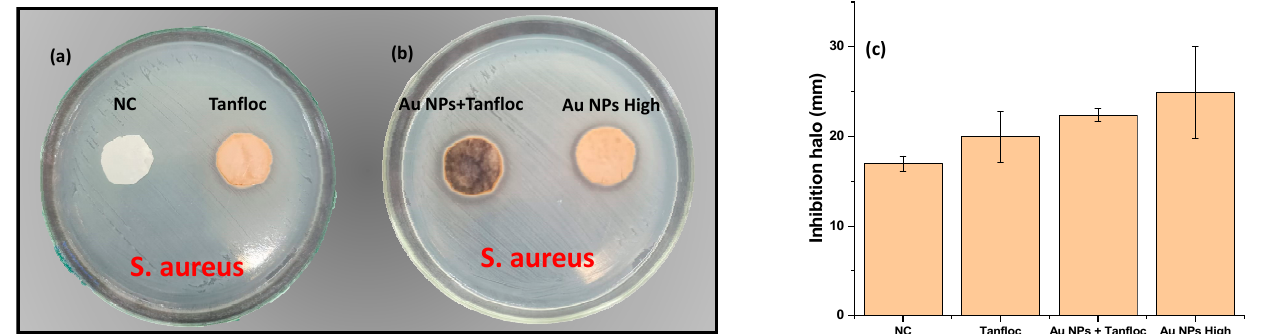
276 Figure 4. ( a ) Antibacterial activity (under progressive dilution) against S. aureus for Tanfloc (C 0 = 0.2 g/mL) (blue) and negative control (black); ( b ) antibacterial activity (under progressive dilution) against S. aureus for the positive control (red), Au NPs High (blue), Au NPs (yellow) and Au NPs + Tanfloc (green). In correspondence, the MBC values against S. aureus for Au NPS High and Au NPs + Tanfloc were C 0 /16 (12.5 mg/mL)—see Figure 4b—confirming the hypothesis that the concentration of Tanfloc dominates in the determination of the MBC of the overall compound. Inhibition halo assays were performed against S. aureus to identify the activity of compounds (in terms of their diffusive properties) in the inhibition of the bacteria. As shown in Figure 5a,b, a discrete inhibition halo is observed for samples Au NPs + Tanfloc,